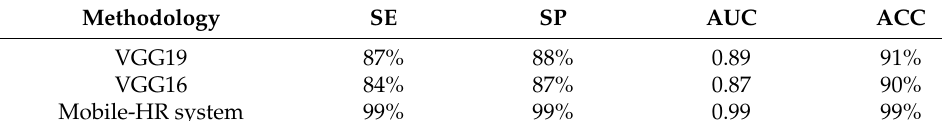
Table 5. Performance comparison between Mobile-HR, VGG16, and VGG16.